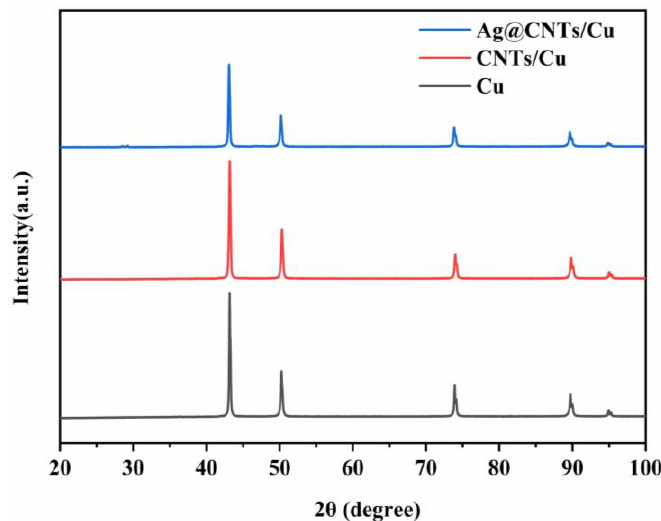
Figure 6. XRD spectra of Cu, CNTs/Cu and Ag-CNTs/Cu powders following reduction.